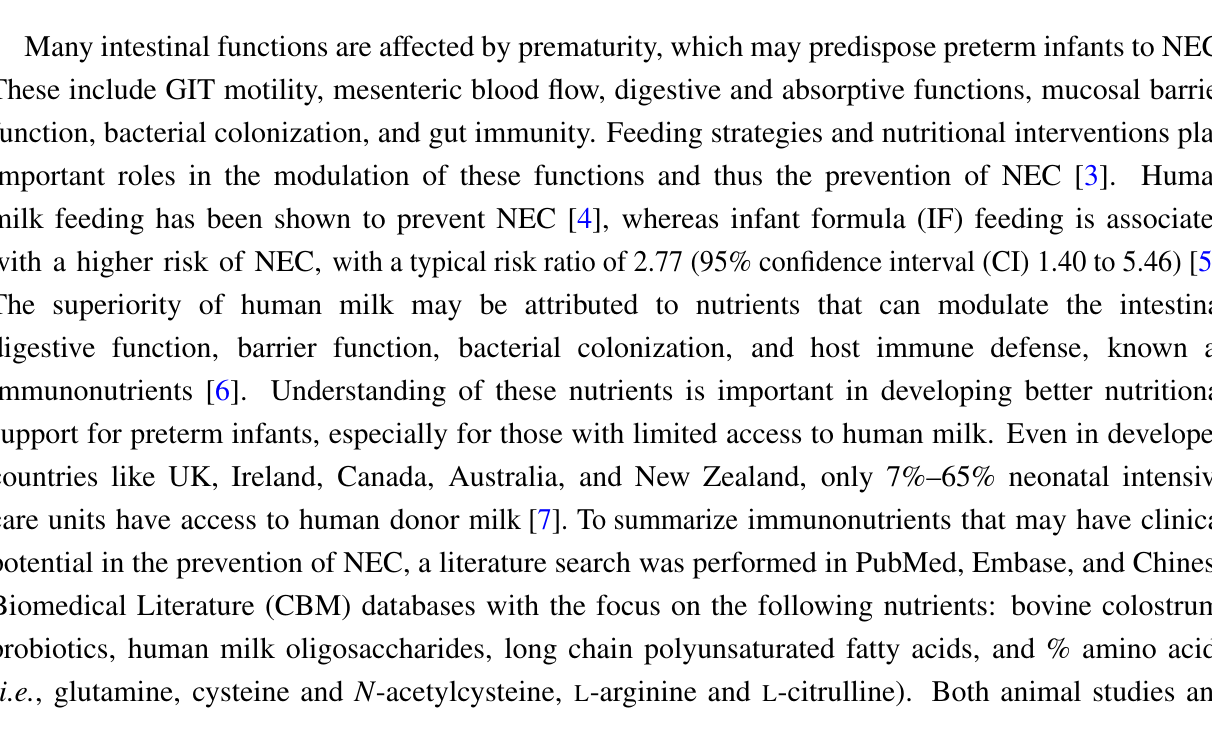
Figure 1. Possible mechanisms involved in the pathogenesis of NEC.